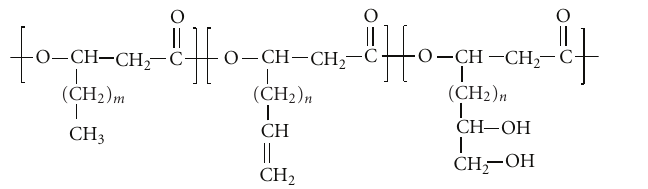
Figure 3: PHOU with pendant hydroxyl groups (PHOU-OH).